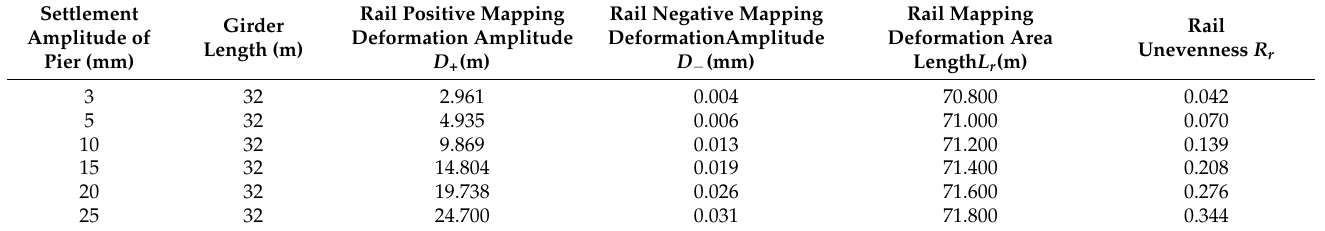
Table 2. Rail mapping deformation area length and rail unevenness of pier settlement.